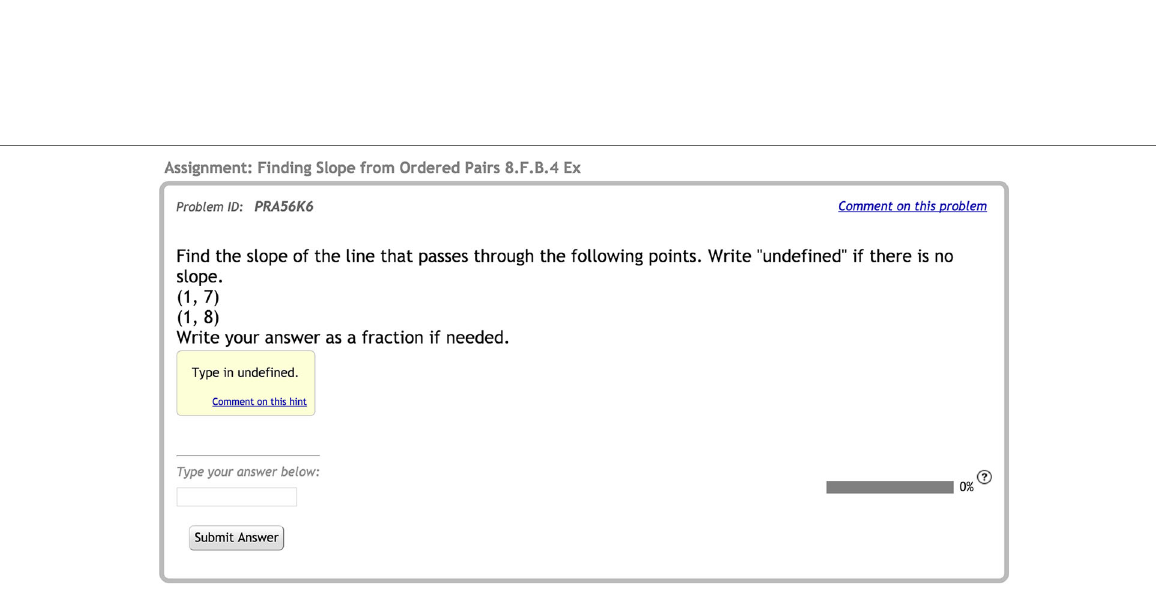
Fig. 2 Hints-early screenshot. An example question from the hints-early condition, showing associated